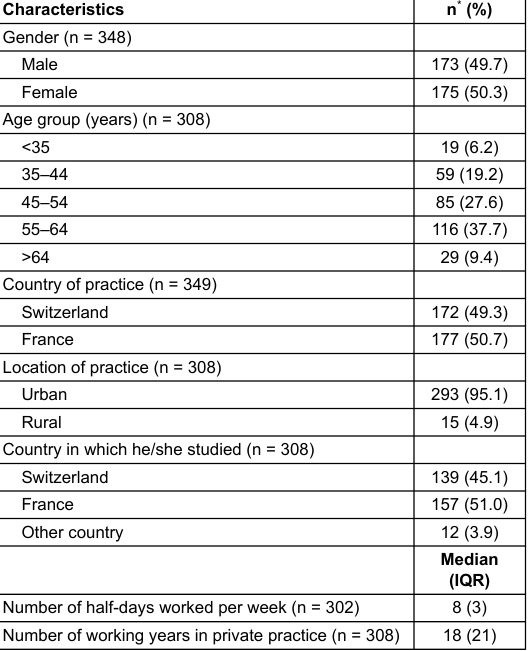
Table 1: General practitioners’ sociodemographic characteristics (n = 349).